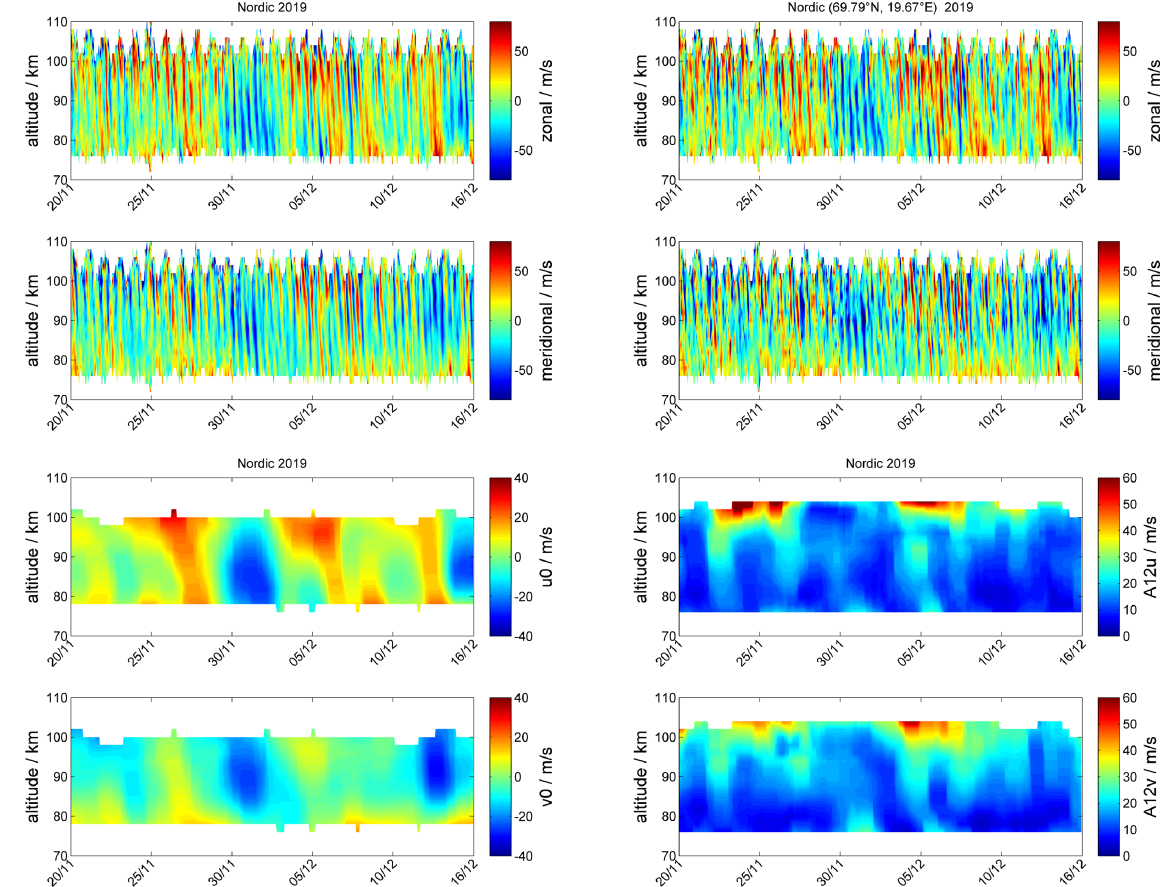
Figure 10. The two left panels show altitude–time–wind (ATW) plots for the zonal and meridional color-coded wind strength integrated over the Nordic domain from 20 November to 15 December 2019. The two right panels highlight the zonal and meridional wind strength for the grid cell located around geographic latitude (69.79 ◦ N, 19.67 ◦ E) for the same period. The two lower rows show the daily mean zonal and meridional wind (left) and the daily semidiurnal tide amplitude for both wind components (right).